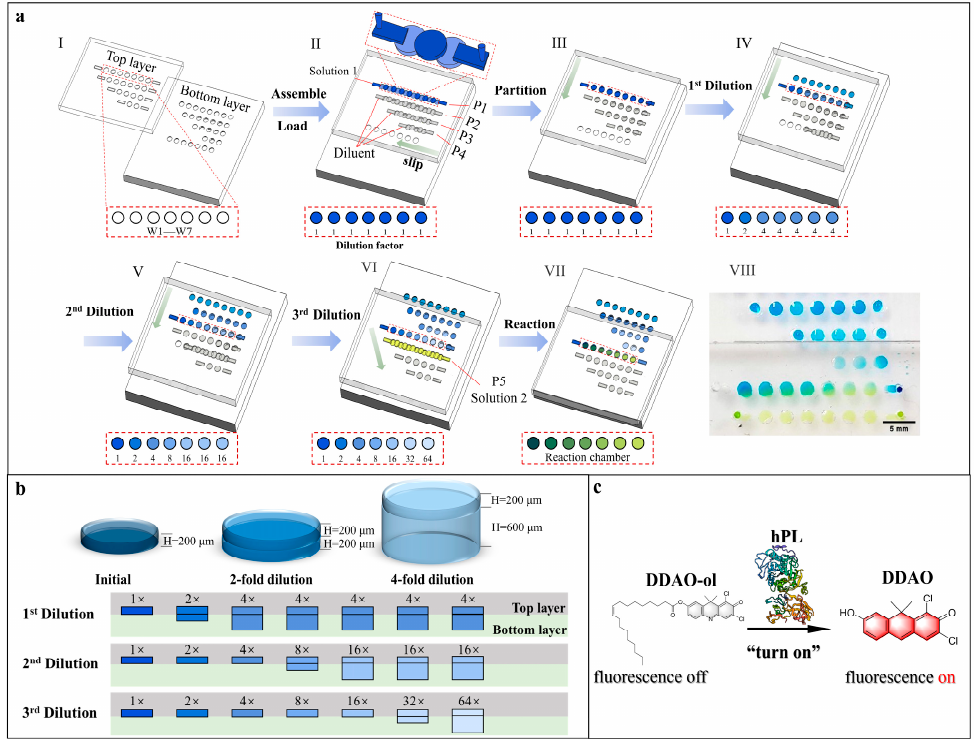
Figure 1. ( a ) Schematic drawings for microfluidic SlipChip operations: (I) top and bottom layers of the SlipChip device; (II) assembly of the SlipChip by partially overlapping the microchambers and ducts on the contacting surface of two layers, original solution (solution 1) and dilution buffer introduced into (P1, P2, P3, P4) channels, respectively; (III) top layer moved left to form isolated reaction partitions; (IV) top layer moved down to perform the 1st dilution step; (V) top layer moved down to perform the 2nd dilution step; (VI) top layer moved down to perform the 3rd dilution step, solution 2 was introduced into (P5) channel; (VII) top layer moved right down to make concentration gradient solution 1 and solution 2 react in chambers; (VIII) photo of the reaction of serial diluted solution 1 (blue ink) and solution 2 (yellow ink) in the chamber. ( b ) Zoom-in view of the assembly of the top and the bottom layer microchambers, and schematic diagram of initial concentration, 2-fold dilution and 4-fold dilution. ( c ) Principle of the enzymatic reaction between hPL and its